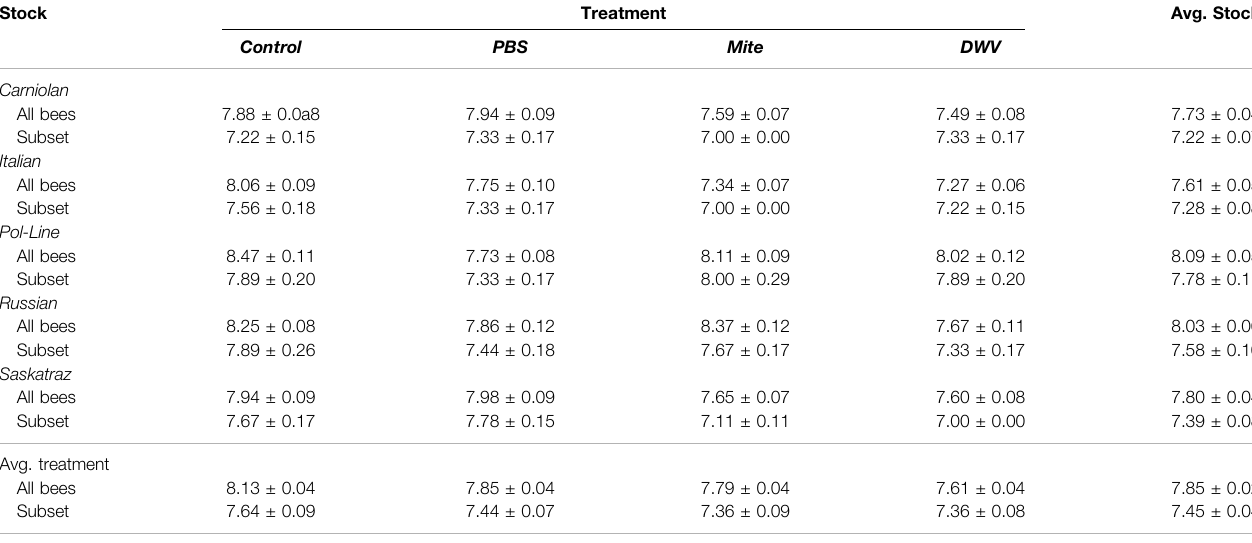
TABLE4| Meandaystoemergence.Themeannumberofdaysuntiladultemergence(±standarderrorofthemean)forallobservedbeesandthenine-beesubset(perstock and treatment combination) used for viral analyses. Stock